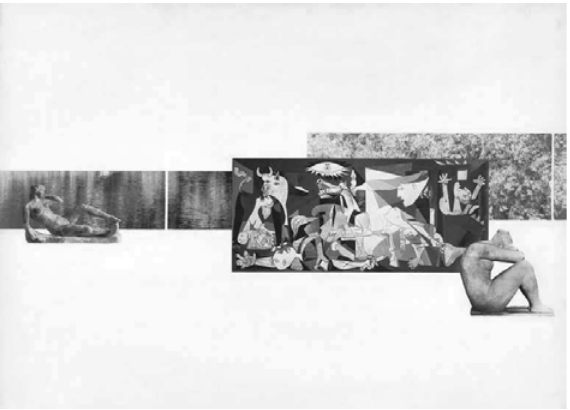
fig. 9. Interior perspective, Museum for a Small City, 1941–43. fig. 10. Interior study, Chapel of St. Ignatius, Seattle university, Washington, 1994–97. © Steven Holl